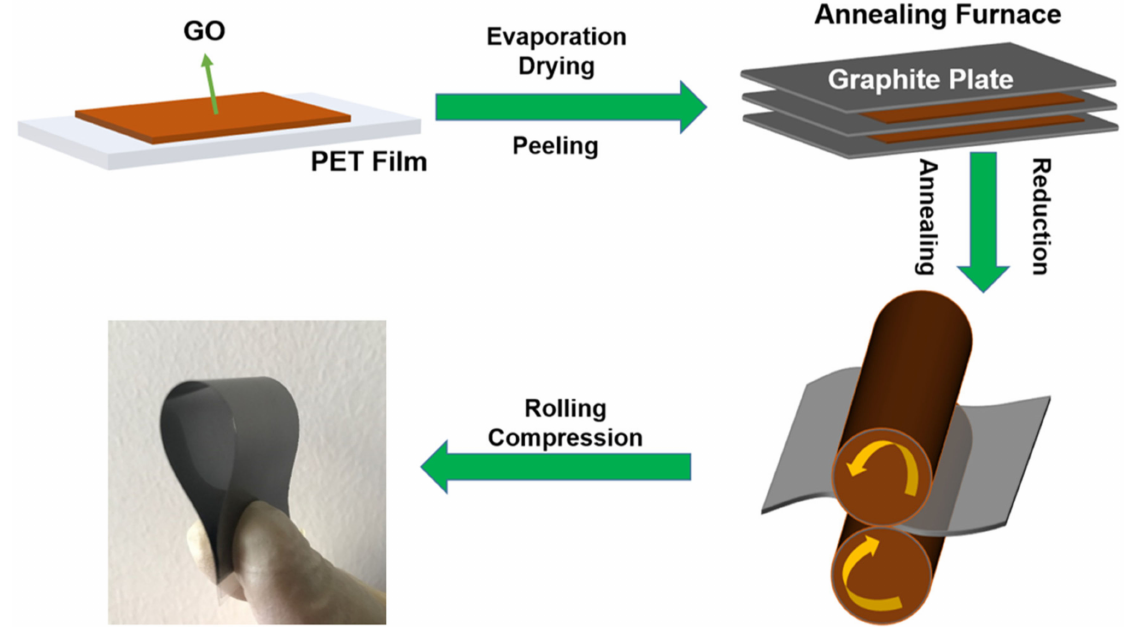
Figure 1. Schematic diagram of high-conductivity graphene assembly film (HCGAF) fabrication process. First, the material structure was inspected with the JSM-7100F scanning electron microscope (SEM). In Figure 2, the cross-sectional and the highly magnified SEM images of the HCGAF show that the film is based on orderly stacked graphene layers with a thickness of 22 µ m. The skin depth, δ s , is related to the frequency and is an intrinsic property of a conductive material. It is defined as the thickness of the material that ensures the effective flow of electrical currents. When the field in the conductor is transmitted a distance of the skin depth, its amplitude decays to 1/e. The δ s of the HCGAF was 12 µ m at 900 MHz; the HCGAF’s thickness had enough space for electrical current flow.